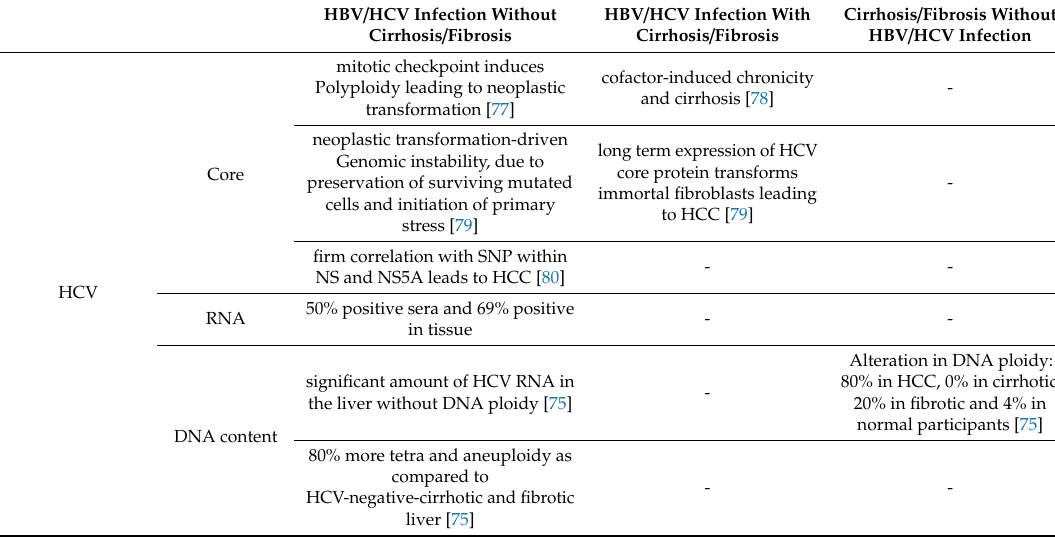
Table 1. Liver cirrhosis / fibrosis with or without HBV / HCV